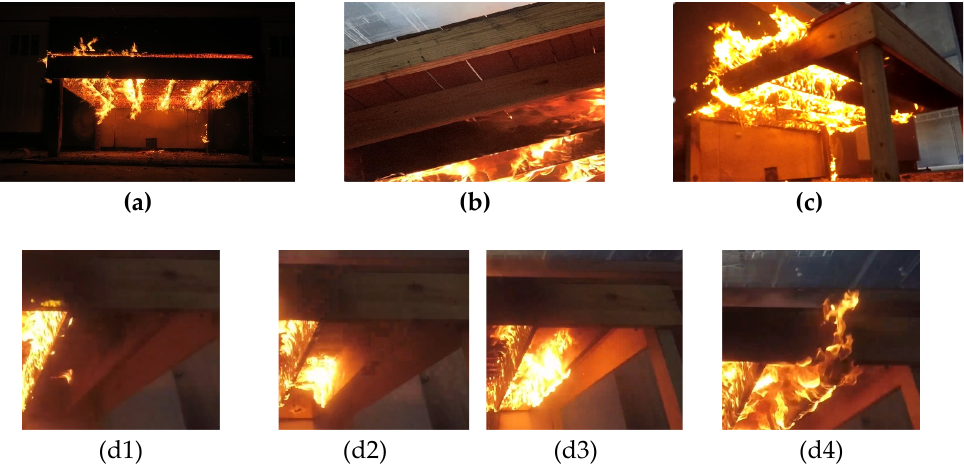
Figure 16. Combustible joists provide a constant heat source to the deck boards, ( a – c ) are from different experiments, ( d1 – d4 ) are taken in one experiment, d1 is taken 6 min after ignition, and ( d2 – d4) are about 4 min apart.